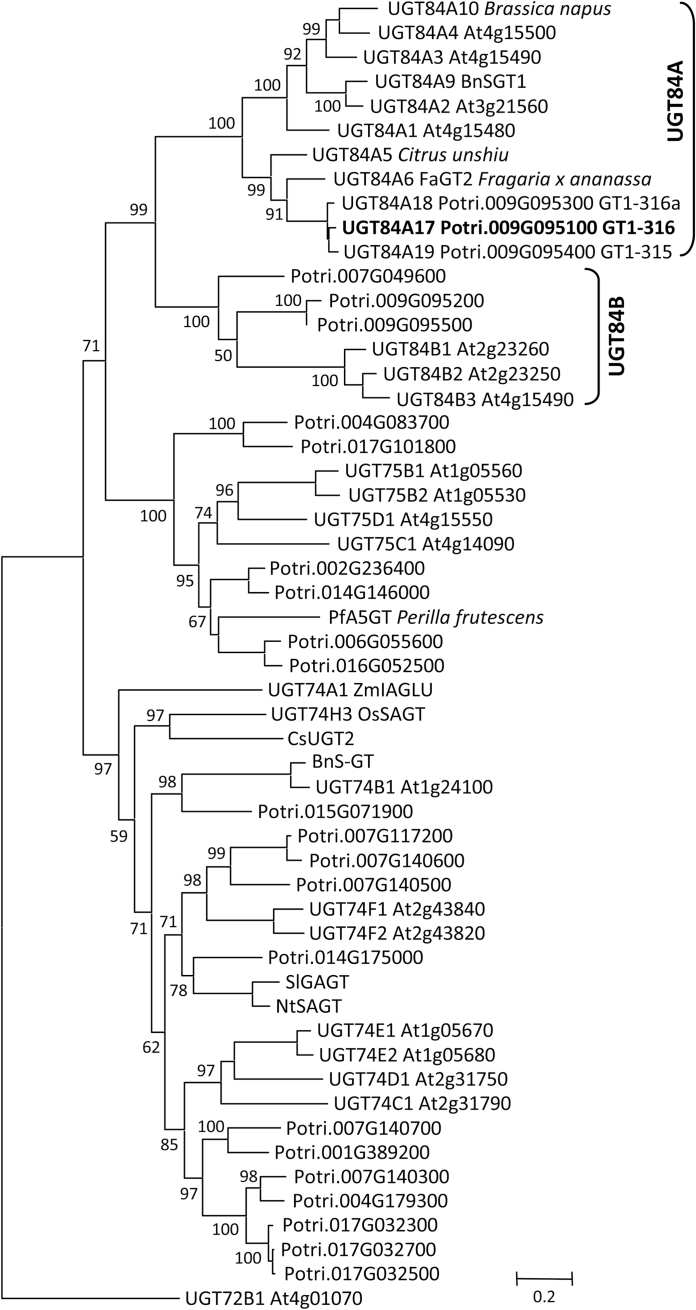
Maximum-likelihood tree of group L glycosyltransferases from Populus and Arabidopsis, along with experimentally characterized members from other species. An Arabidopsis group E member (UGT72B1) was used as outgroup. Bootstrap support for the branches is shown. Populus gene models were from the genome release v3.0 (Phytozome), whereas the Arabidopsis sequences were from TAIR10. GenBank accession numbers for the other sequences are: Brassica napus UGT84A9/BnSGT1 (AF87143), UGT84A10 (CAJ77650), and BnS-GT (AAL09350); Crocus sativus CsUGT2 (Q6X1C0); Fragaria × ananassa FaGT2/UGT84A6 (Q66PF4); Citrus unshiu UGT84A5 (BAA93039); Nicotiana tabacum NtSAGT (AF190634); Oryza sativa UGT74H3/OsSAGT (BAD34358); Perilla frutescens var. crispa PfA5GT (BAA36421); Solanum lycopersicum SlGAGT (CAI62049); and Zea mays UGT74A1/ZmIAGLU (AAA59054). UGT code assigned by the UDP Glucuronosyltransferase Nomenclature Committee is included when available.